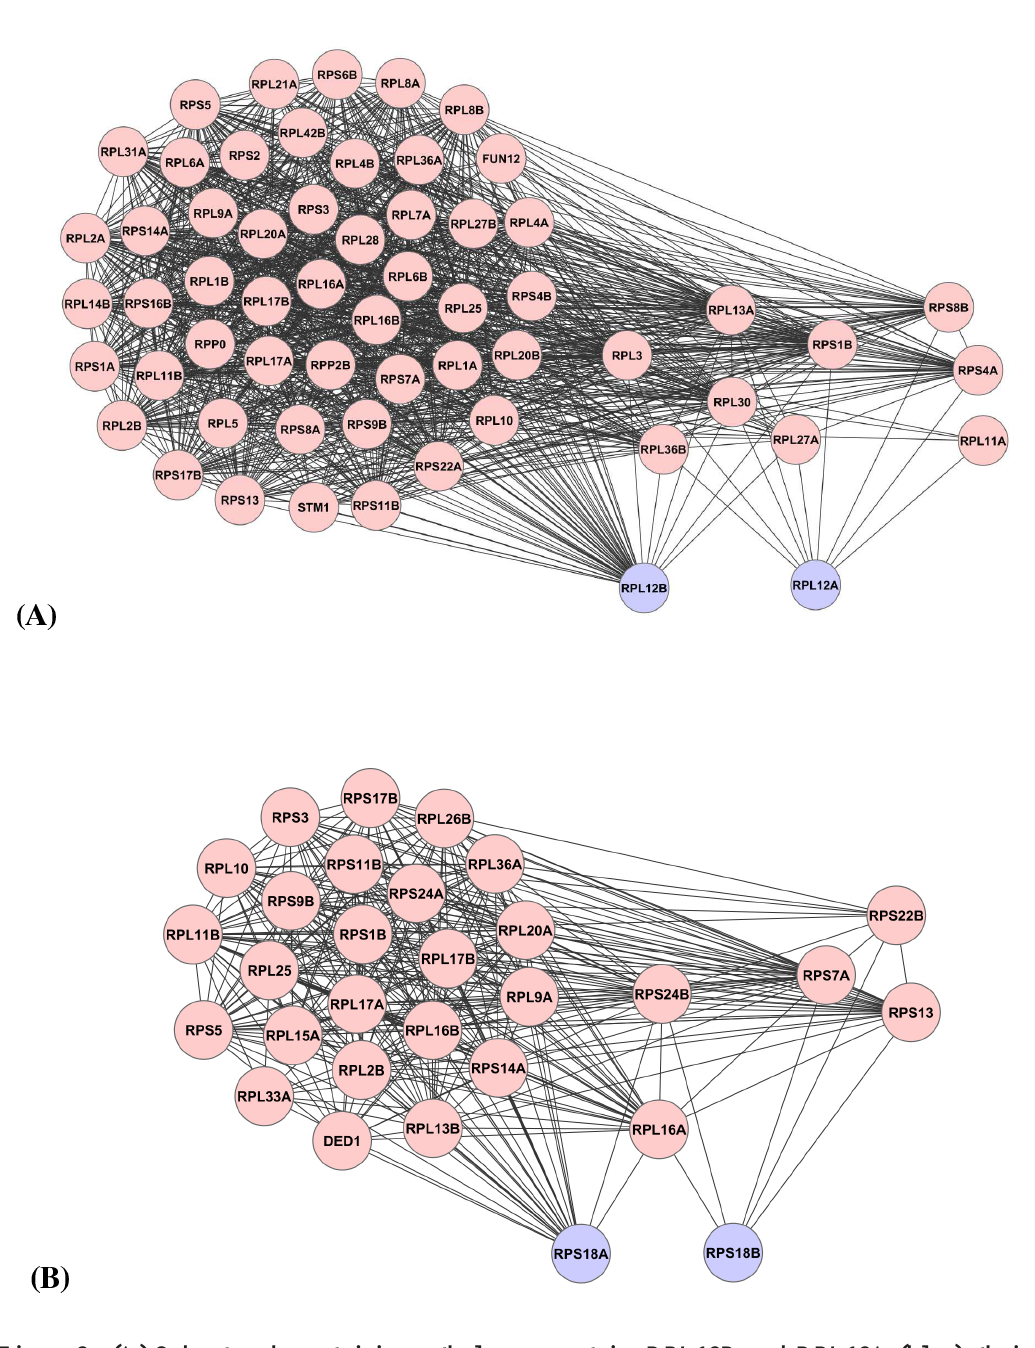
Figure 3: (A) Subnetwork containing orthologous proteins RPL12B and RPL12A (blue), their direct neighbors (pink), and all interactions in the yeast PPI network that exist between these nodes. The subnetwork contains 59 nodes and 1,262 interactions. RPL12B interacts with 54 proteins, while RPL12A interacts with 9 proteins. Proteins RPL12B and RPL12A have identical sequences, but graphlet degree signature similarity in the PPI network of 65%. (B) Subnetwork containing orthologous proteins RPS18A and RPS18B (blue), their direct neighbors (pink), and all interactions in the yeast PPI network that exist between these nodes. The subnetwork contains 30 nodes and 346 interactions. RPS18A interacts with 25 proteins, while RPS18B interacts with 5 proteins. Proteins RPS18A and RPS18B have identical sequences, but graphlet degree signature similarity in the PPI network of